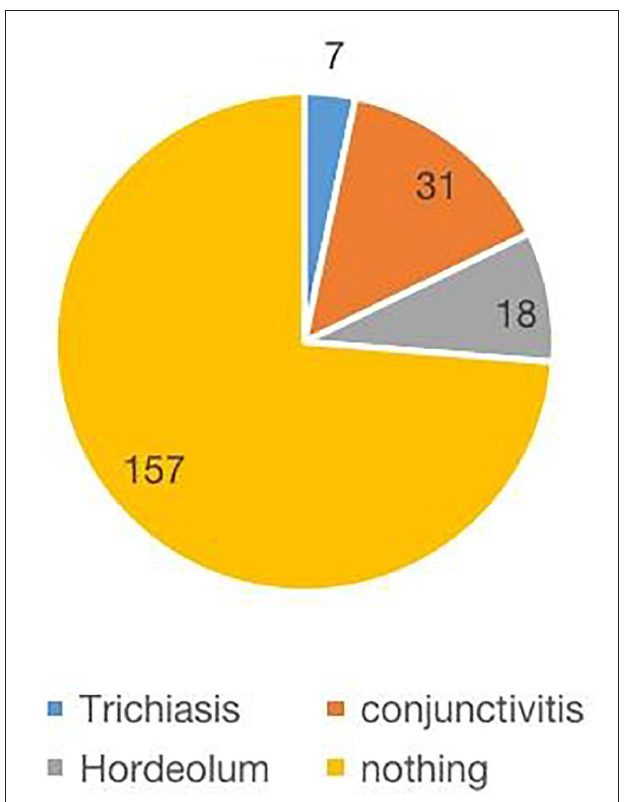
FIGURE 4 | History distribution of eyelid conjunctiva.